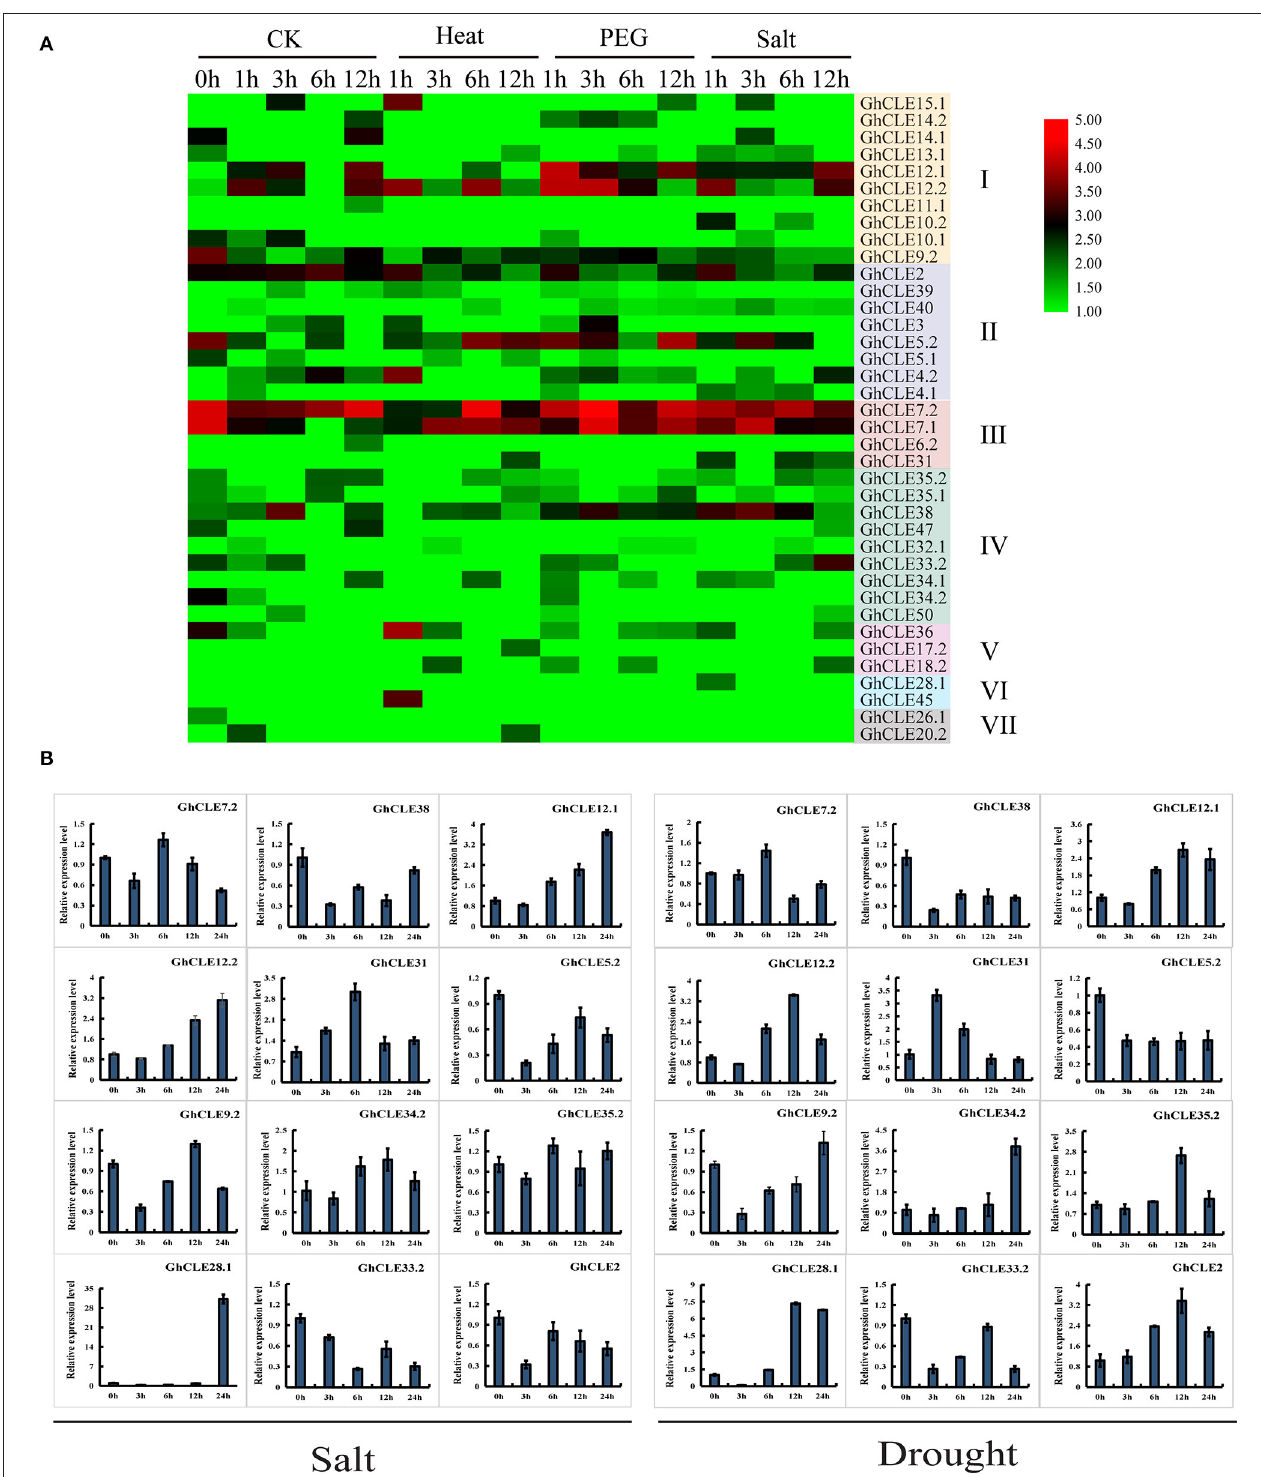
FIGURE 6 | Expression patterns of GhCLEs under different stress. (A) Stress-induced expression patterns of GhCLEs under polyethylene glycol (PEG), and salt treatments for 1-, 3-, 6-,12-, and 24-h, respectively. Heat maps are drawn in the same way as in Figure 5 . (B) Relative expression levels of 12 GhCLE genes under different